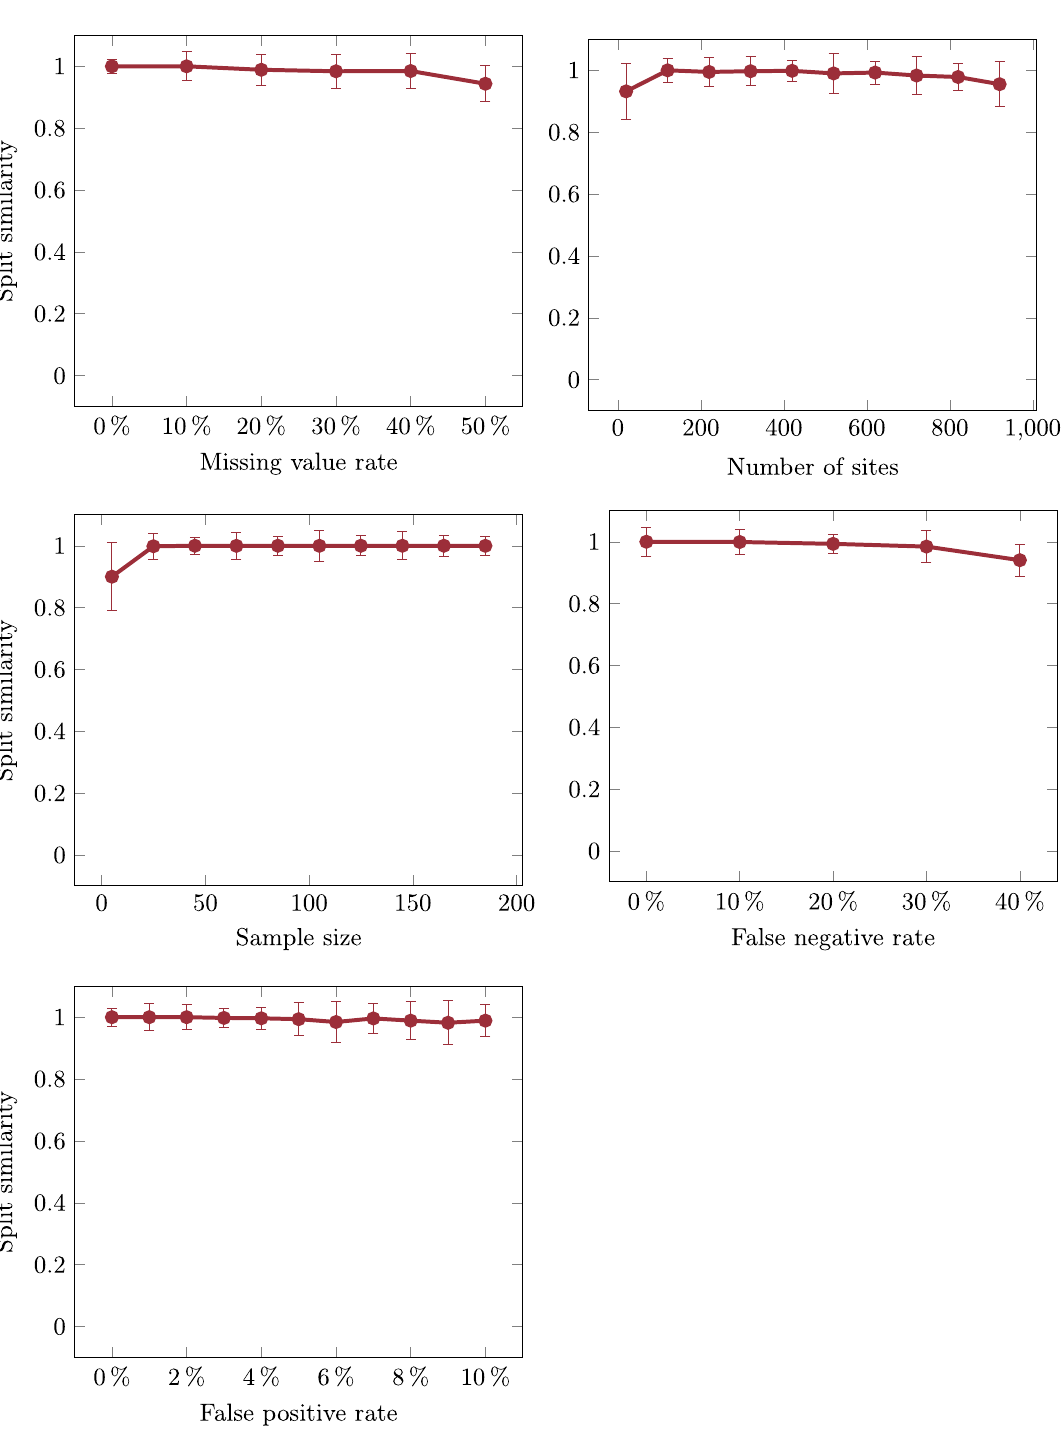
PLOS Computational Biology | https://doi.org/10.1371/journal.pcbi.1009100 August 11,